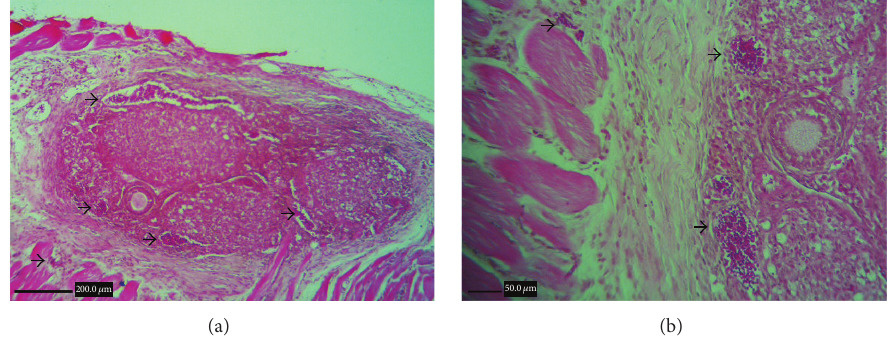
Figure 1: (a) Corpora lutea and secondary follicle in the section confirm ovarian function and folliculogenesis after 21 days’ autologous ovarian transplantation in lateral lumbar muscles of mice without superovulation. (b) Angiogenesis, arrows show presence of blood cells in vessels of transplanted ovary and surrounding skeletal muscles. H&E